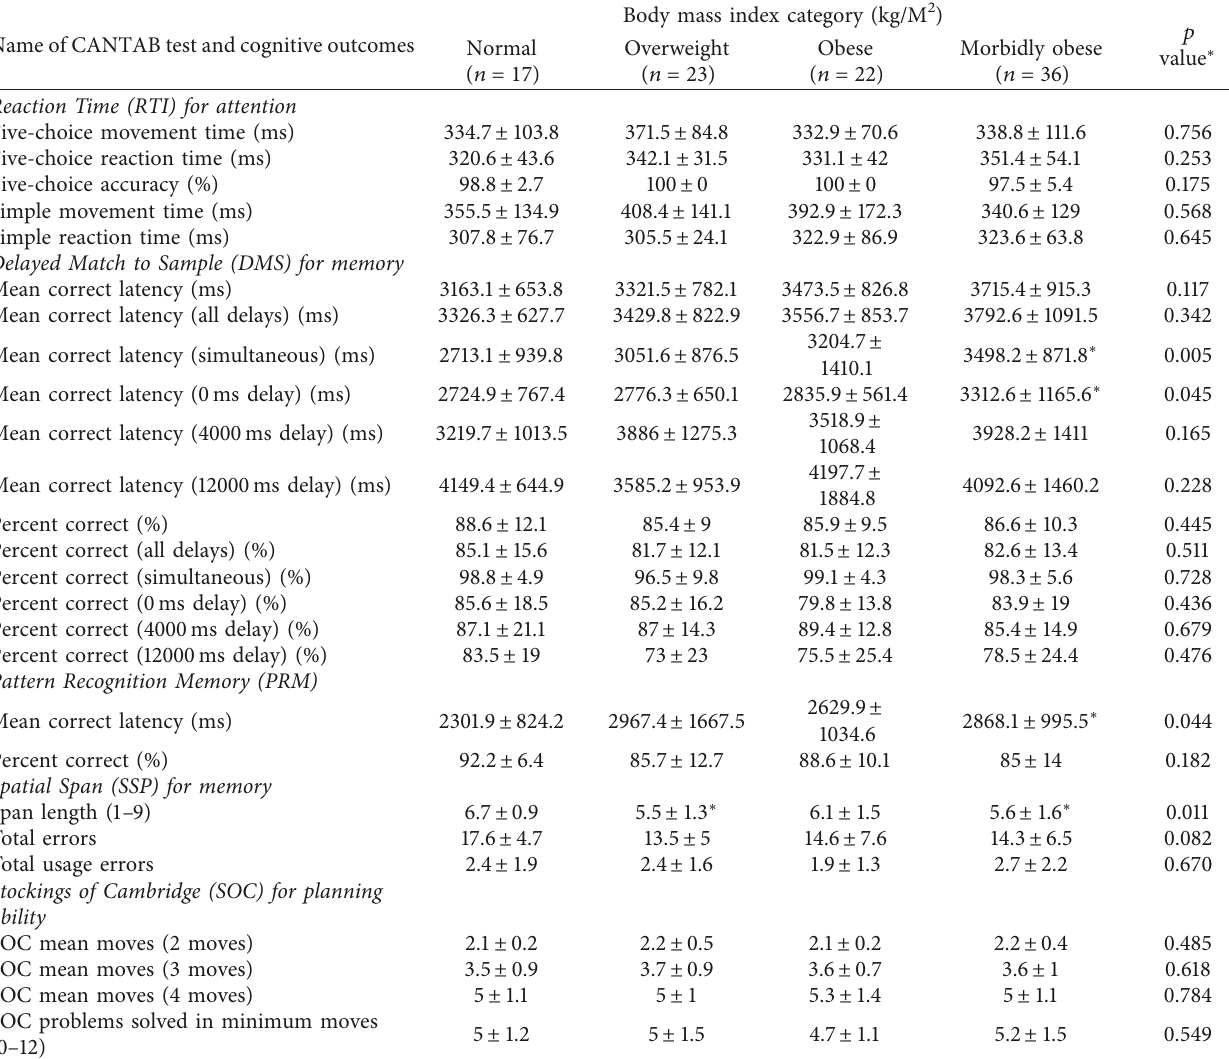
Table 2: Association of BMI categories with cognitive outcomes (attention, memory, and planning ability). Name of CANTAB test and cognitive